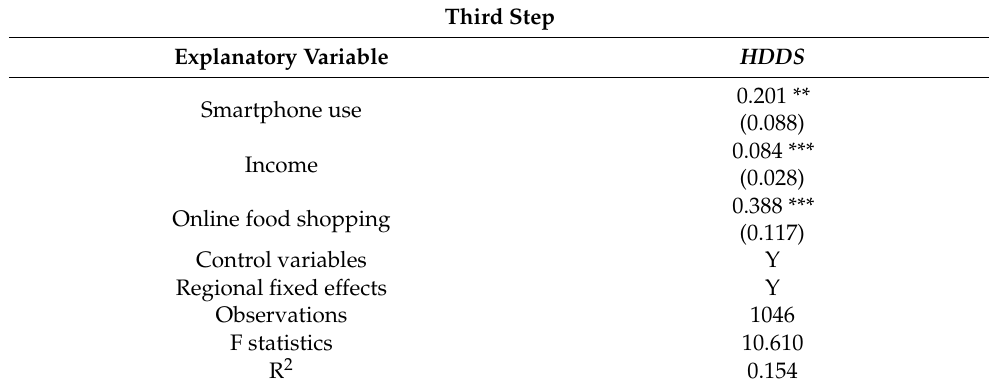
Table 8. Mechanism analysis: Step (3).